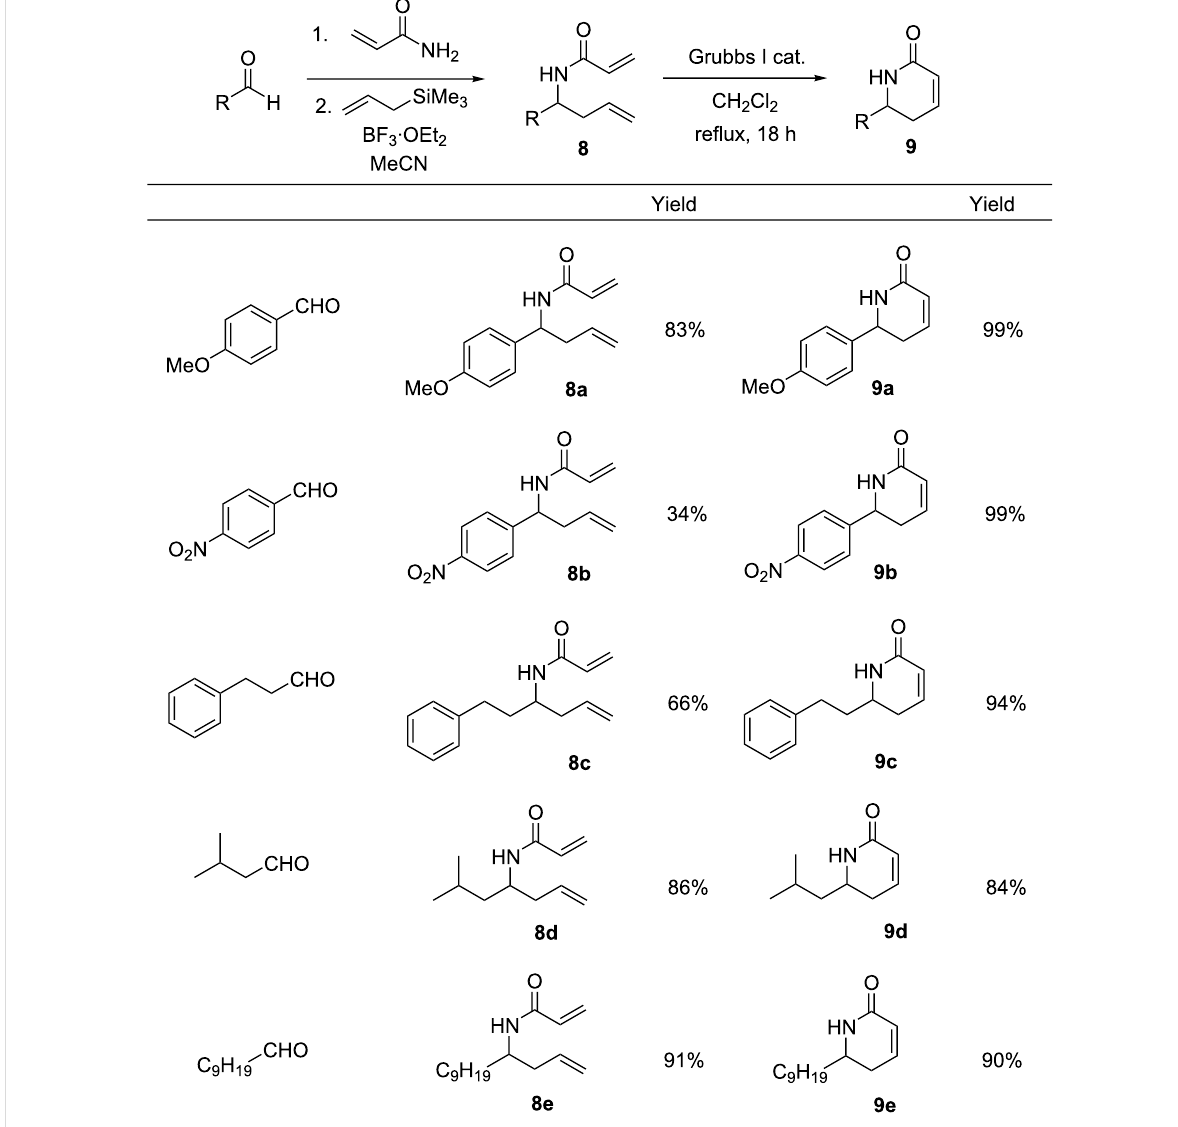
Figure 2: Extension of the two-pot methodology to include a variety of different aldehyde starting materials.